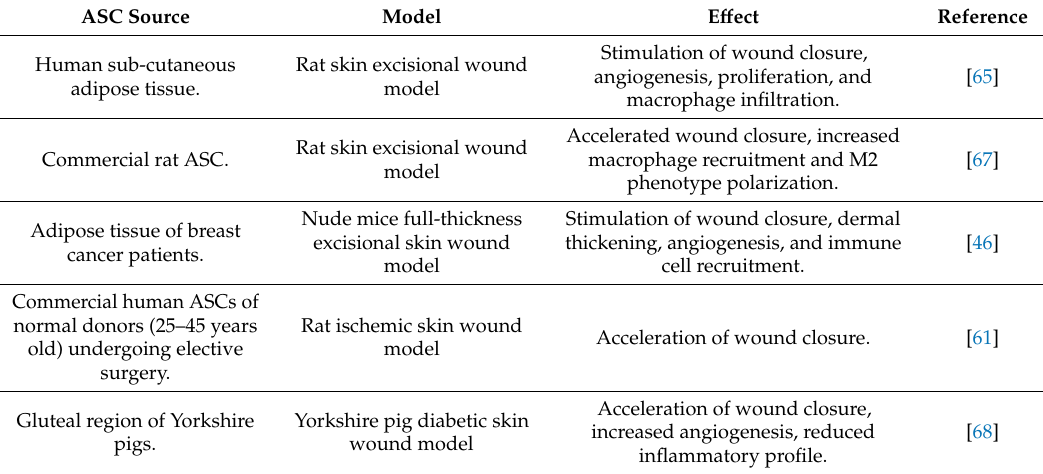
Table 2. E ff ects of ASC-conditioned medium / secretome on wound healing: In vivo studies. ASC Source Model E ff ect Reference Stimulation of wound closure, Human sub-cutaneous Rat skin excisional wound angiogenesis, proliferation, and adipose tissue. model macrophage infiltration. Accelerated wound closure, increased Rat skin excisional wound Commercial rat ASC. macrophage recruitment and M2 model Nude mice full-thickness Stimulation of wound closure, dermal Adipose tissue of breast excisional skin wound thickening, angiogenesis, and cancer patients. model